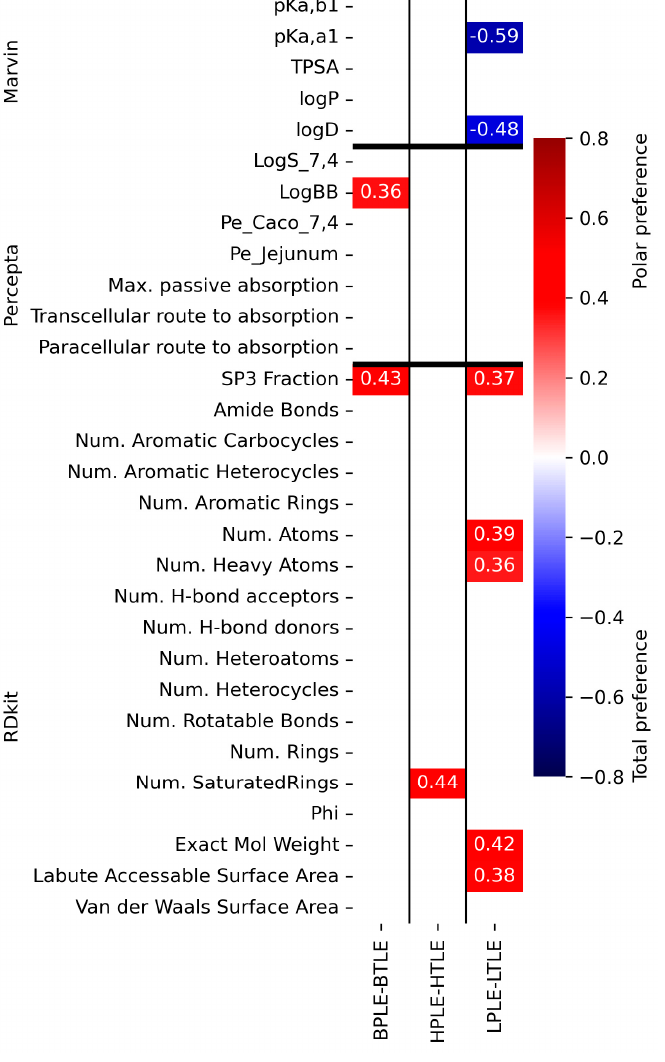
Figure 14. Spearman correlation matrix between the descriptors and the tissue-related polar (red) and total (blue) preferences. Only the most significant correlation values are shown with a signifi- cance level of p < 0.05. The predicted descriptors and permeability data (n = 3) can be found in Tables S1 and S2 in the Supplementary Material, respectively.